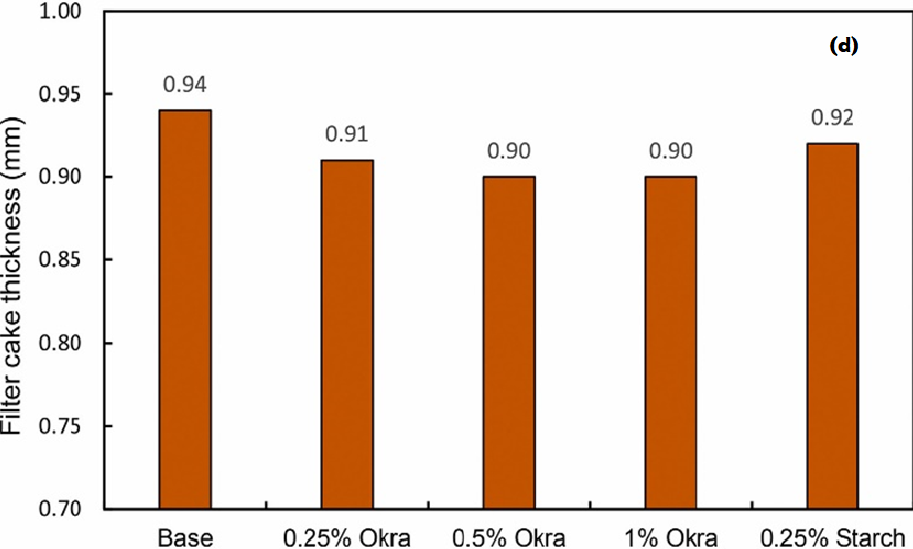
Figure 5. Graphical representation of okra powder as an eco-friendly additive in water-based drilling fluids. Increase in plastic viscosity, yield point, apparent viscosity, and gel strength ( a , b ), and decrease in fluid loss and mud cake thickness ( c , d ), using various additive concentrations (%) of okra powder versus starch [59].